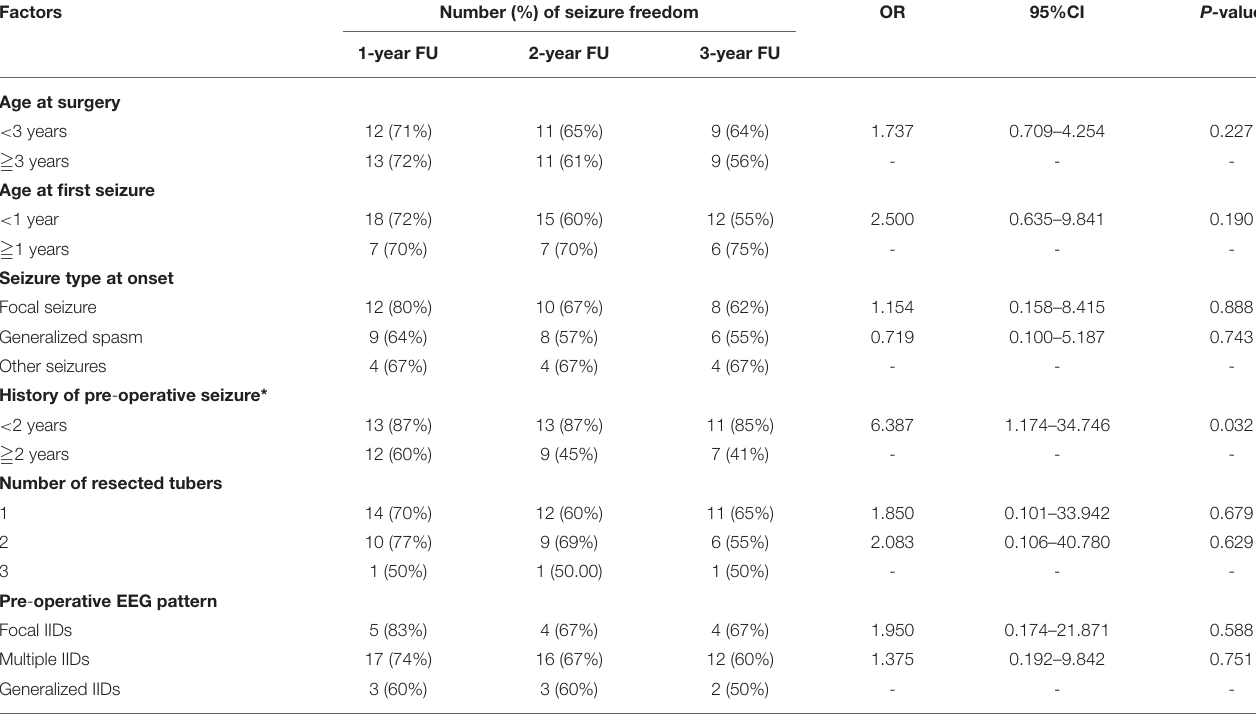
TABLE 2 | Relationship of pre-operative influence factors and number of resected tuber and post-operative seizure freedom.